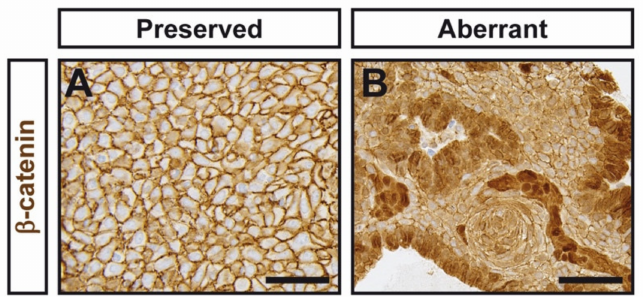
Figure 3. Immunohistochemical detection of β -catenin in CPs assessed by immunohistochemistry. ( A ) Representative picture of a CP showing preserved β -catenin accumulation. ( B ) Representative picture of a CP showing aberrant β -catenin accumulation. Scale bar: 50 µ